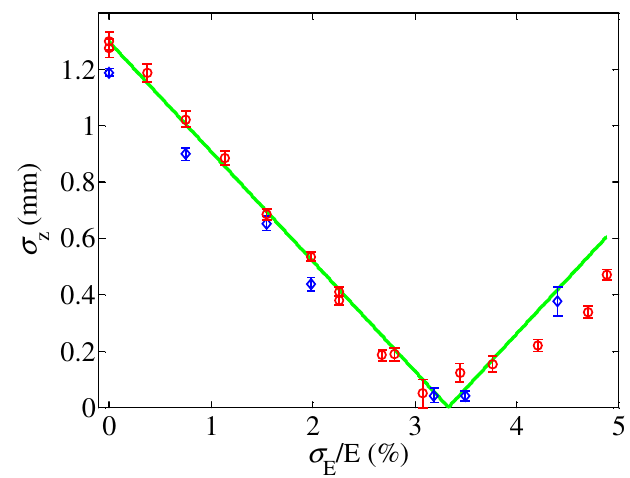
FIG. 37. (Color) The rms bunch length at 250 MeV after BC1, measured using the 2nd rf deflector (red circles), and the mea- sured compression factor times the initial bunch length (blue diamonds), measured using two beam phase monitor cavities up and downstream of BC1. The (linear) calculated bunch length is also shown (green